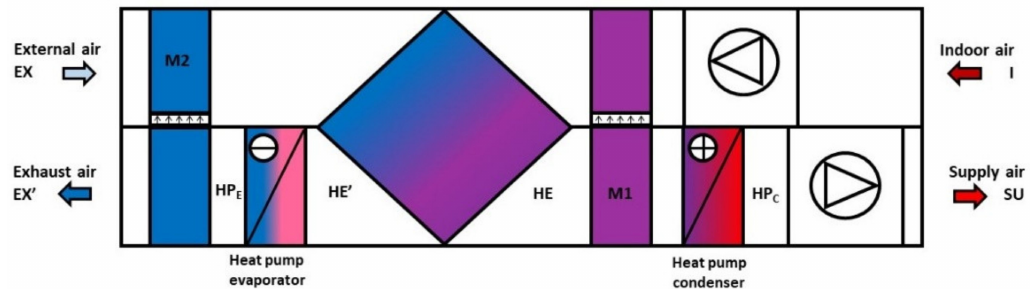
Figure 2. Swimming pool ventilation unit with a heat pump and an air and water condenser [23] M2—air parameters in the external recirculation mixing chamber, HP E —air parameters after the heat pump’s evaporator, HP C —air parameters after the heat pump’s condenser (other points as in Figure